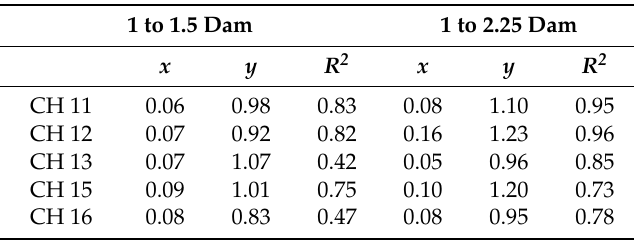
Table 5. Coefficients used in the prediction of 𝑄 (cid:3040)(cid:3028)(cid:3051) for each channel using Equation (7). CH, channel.